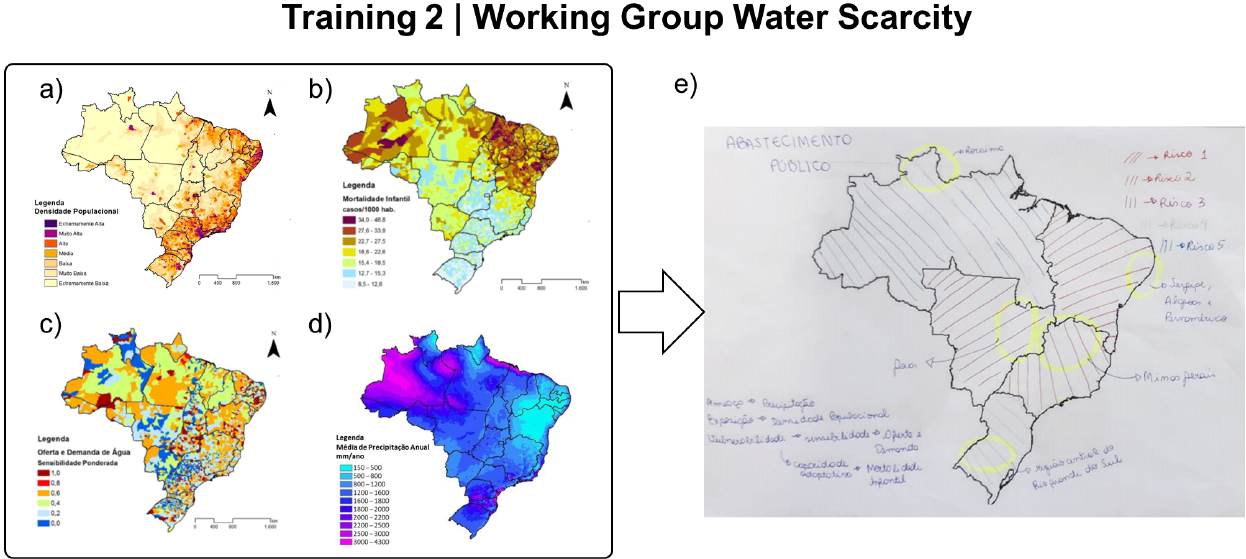
Figure A7. Package of maps used in the second training for mapping climate risk associated with water scarcity. The maps illustrate (a) population density (MMA, 2017), (b) child mortality (MMA, 2017), (c) water supply and demand (MMA, 2017), (d) annual precipitation (MMA, 2017), and (e) the climate risk map drawn by the